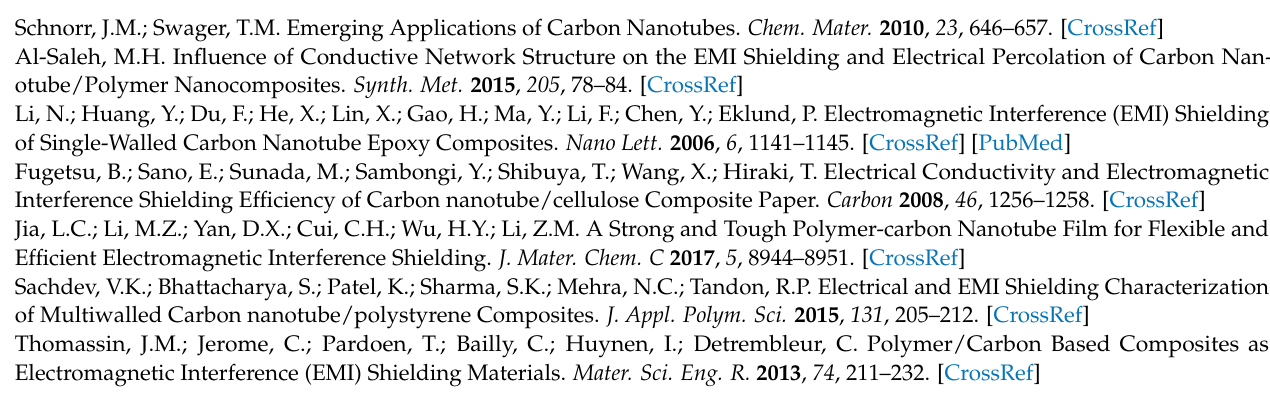
1-10. Table S2: Parameters of CNTF in composite prepreg. Table S3: Comparison of EMI